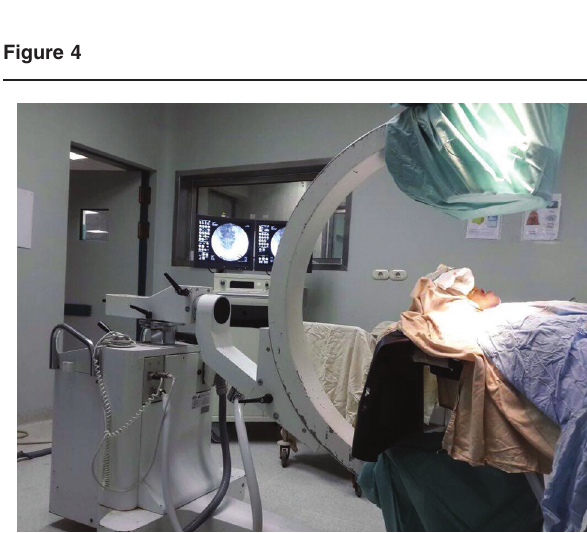
C-arm application by an extraoral approach while the patient was lying in the supine position under general anesthesia during open reduction and